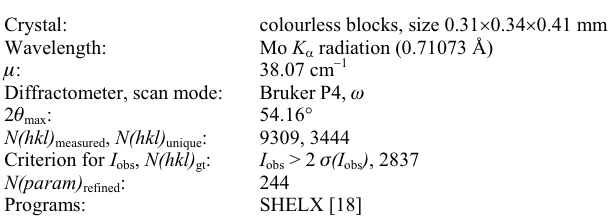
Table 1. Data collection and handling.